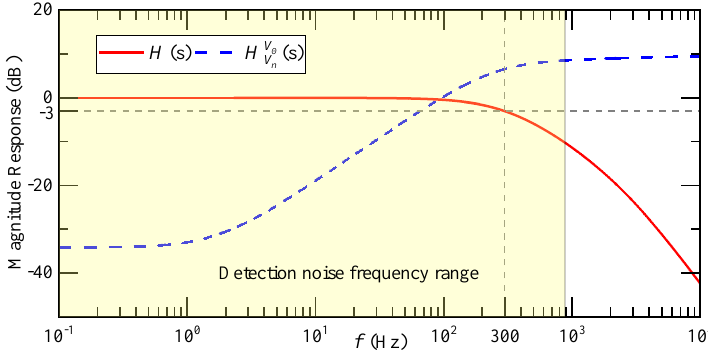
𝑉 0 (𝑠) . Figure 7. Amplitude-frequency characteristics of H ( s ) and H V 0 ( s ) . 𝑉 𝑛 V n